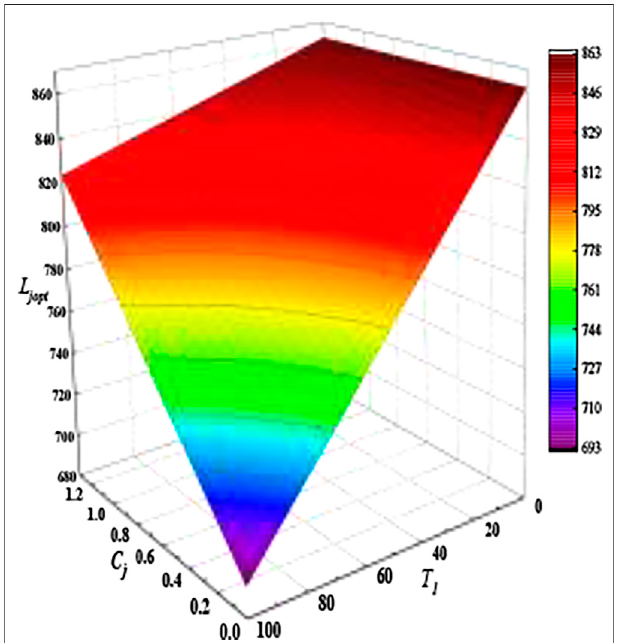
FIGURE 5 | Optimal pro fi t and carbon allowance of building materials business, external carbon price.